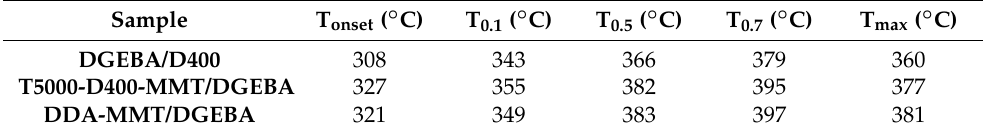
Figure 10. Pressure of permeated N 2 as a function of time through neat DGEBA/D400 epoxy resin and the nanocomposites reinforced by Na-MMT, T5000-D400-MMT and DDA-MMT at 3 wt % clay loading.